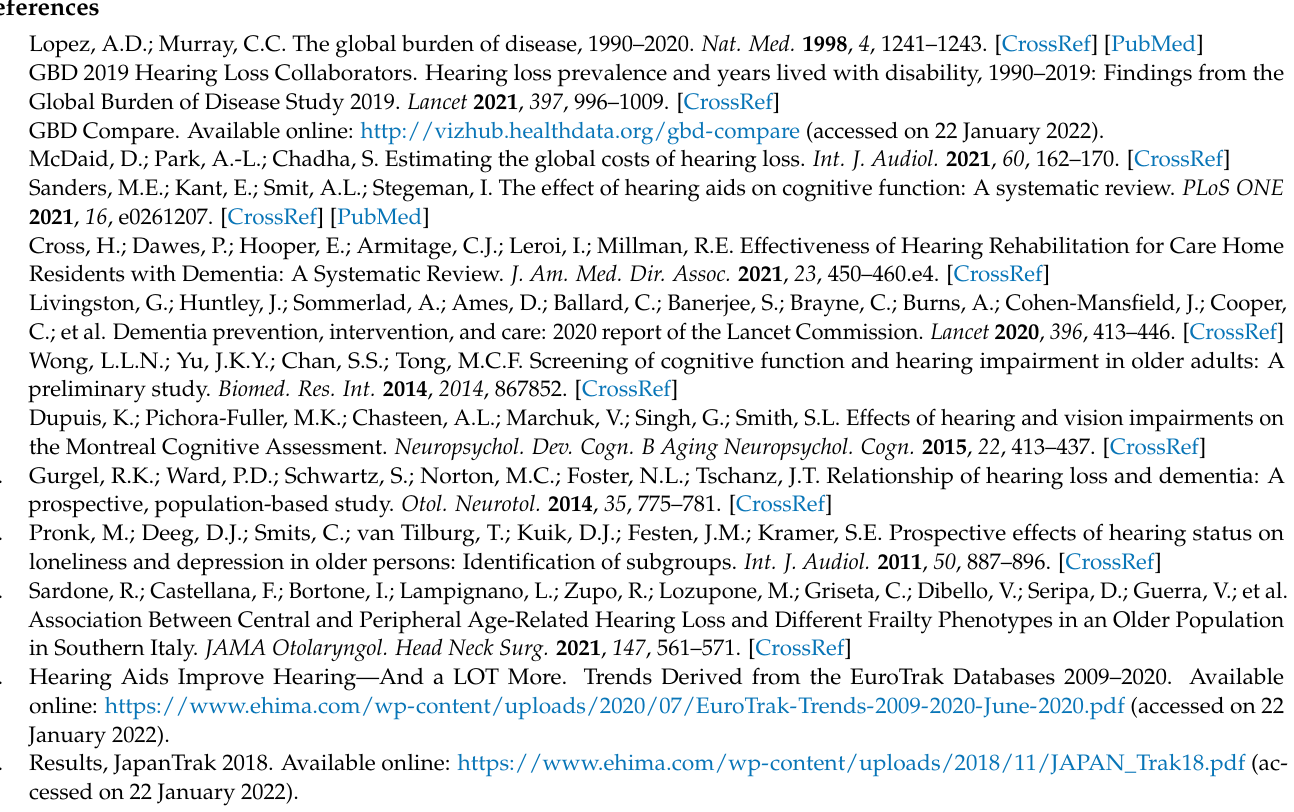
Insurance Act. Table S3: Distribution of participants according to the Law for the Welfare of Physically Disabled Persons in Japan based on 1000 Hz-weighted average. Table S4: Distribution of participants according to the Labor Standards Act in Japan based on middle-range weighted